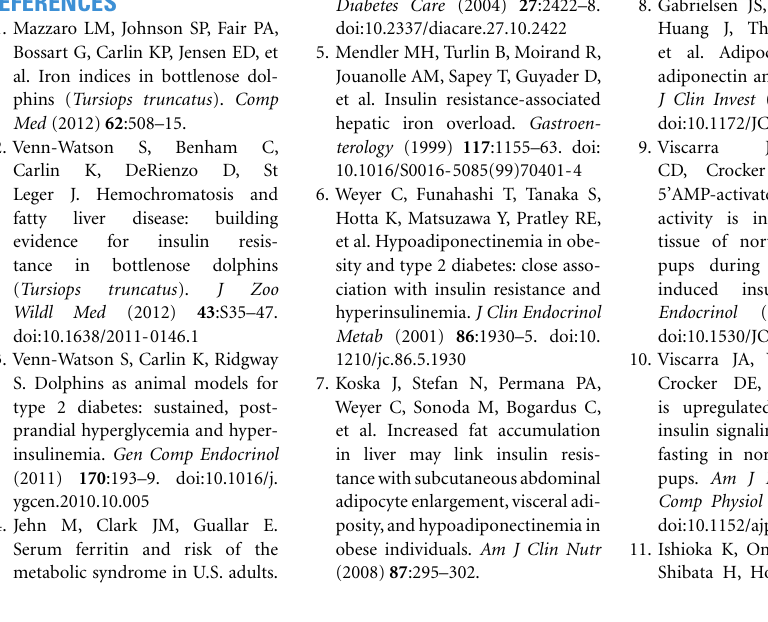
Figure S6 | External calibration curves for y9 from GDTGETGVTGVEGPR . The solid line represents the 1/x weighted linear regression, R =0.9873. Inset is provided to show performance at lower concentrations. Figure S7 | External calibration curves for yl0 from GDTGETGVTGVEGPR . The solid line represents the 1/x weighted linear regression, R =0.98691. Inset is provided to show performance at lower concentrations.